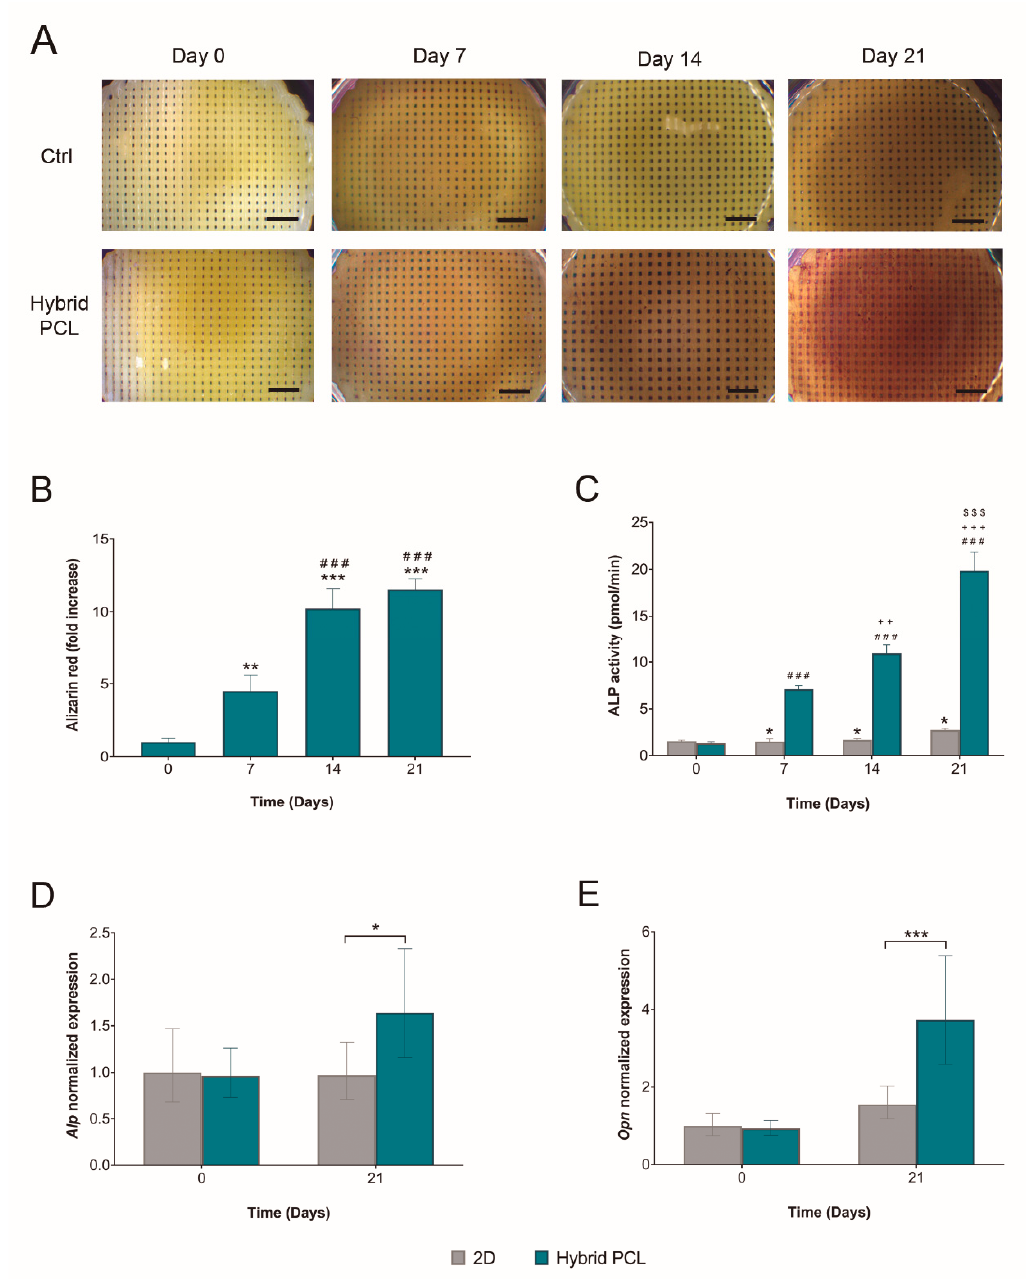
Figure 4. Osteogenic differentiation of MC3T3-E1 cells cultured on hybrid PCL scaffolds. ( A ) Optical images of calcium deposits stained with Alizarin Red S. Scale bars = 2.5 mm. ( B ) Quantification of the calcium deposits stained with Alizarin Red S. Statistical significance: ** p < 0.01, *** p < 0.001 compared to day 0. ### p < 0.001 compared to day 7. ( C ) Overtime intracellular ALP activity determination in MC3T3-E1 cells cultured either on hybrid PCL scaffolds or on regular culture plates (2D). Statistical significance: * p < 0.05 compared to cells cultured on hybrid PCL scaffolds at that same time point. ### p < 0.001 compared to cells cultured on hybrid PCL at day 0. +++ p < 0.001, ++ p < 0.01 compared to cells cultured on Hybrid PCL at day 7. $$$ p < 0.001 compared to cells cultured on hybrid PCL at day 14. ( D ) Alp and ( E ) Opn expression in MC3T3-E1 cells cultured either on hybrid PCL scaffolds or on regular culture plates (2D), all normalized to 1 as fold increase of day 0. Gapdh was used as reference gene. Statistical significance: * p < 0.05, *** p < 0.001. Results are shown as the mean ± standard deviation in ( A , B ), and as mean ± S.E in ( C , D ), ( n = 4).